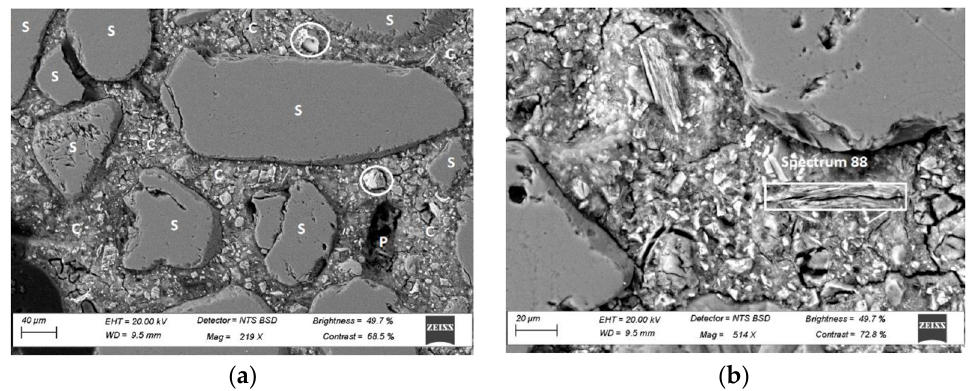
Figure 10. ( a ) SEM image showing the different particles in the BFN mortar matrix and white circles showing unhydrated cement grains, ( b ) SEM image of metakaolin particle in the inter transitional zone (ITZ) of the mortar paste between the aggregates.